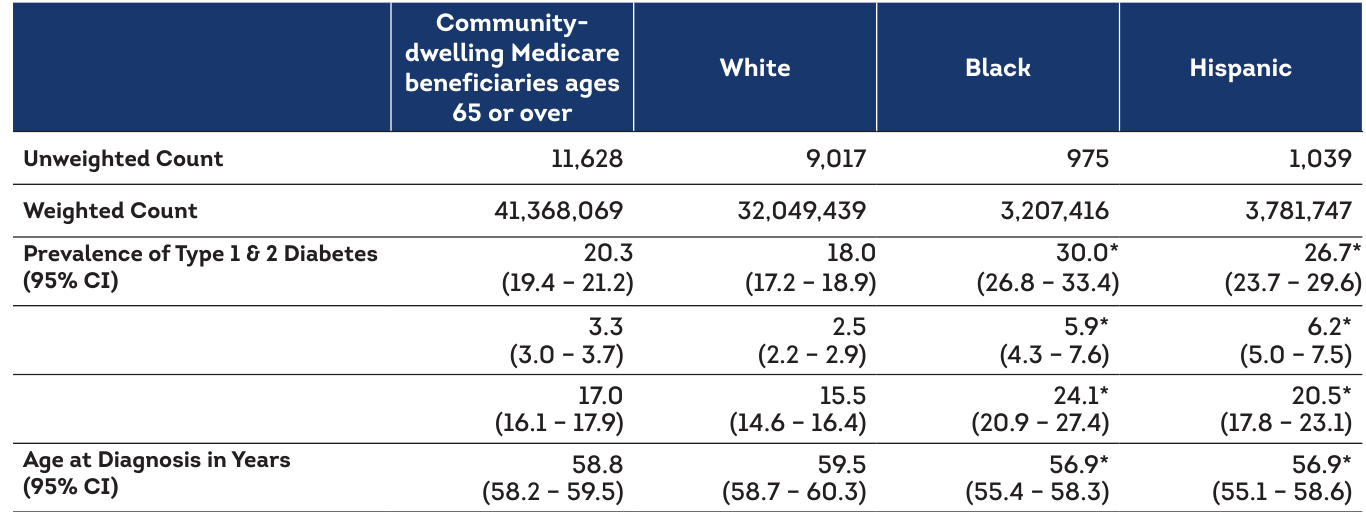
Table A1: Prevalence and age at onset of diabetes, by race and ethnicity Community- dwelling Medicare White